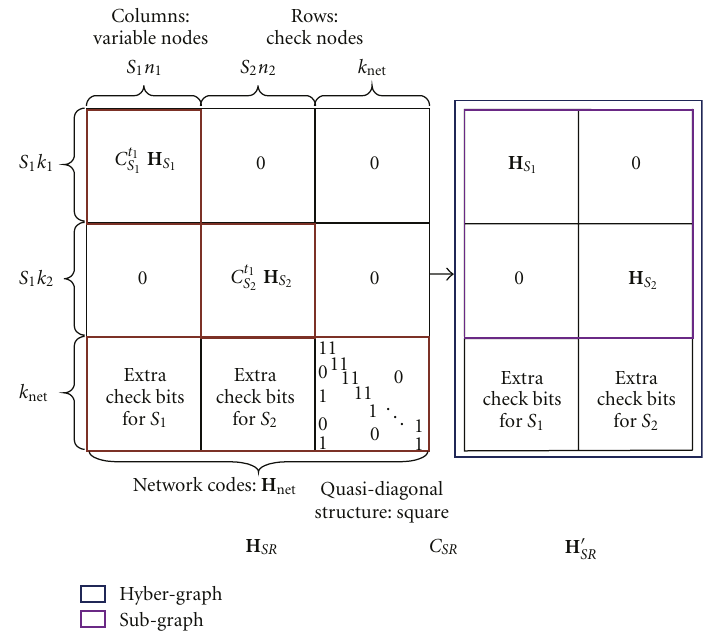
Figure 6: The cooperative design framework of parity-check network